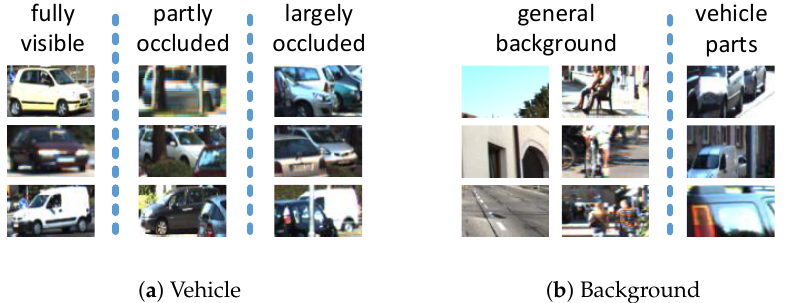
Figure 3. Training samples consist of vehicles ( a ) and backgrounds ( b ). Vehicle category is divided into three types according to extent of occlusion; background category is divided into two types according to whether vehicle part appears.